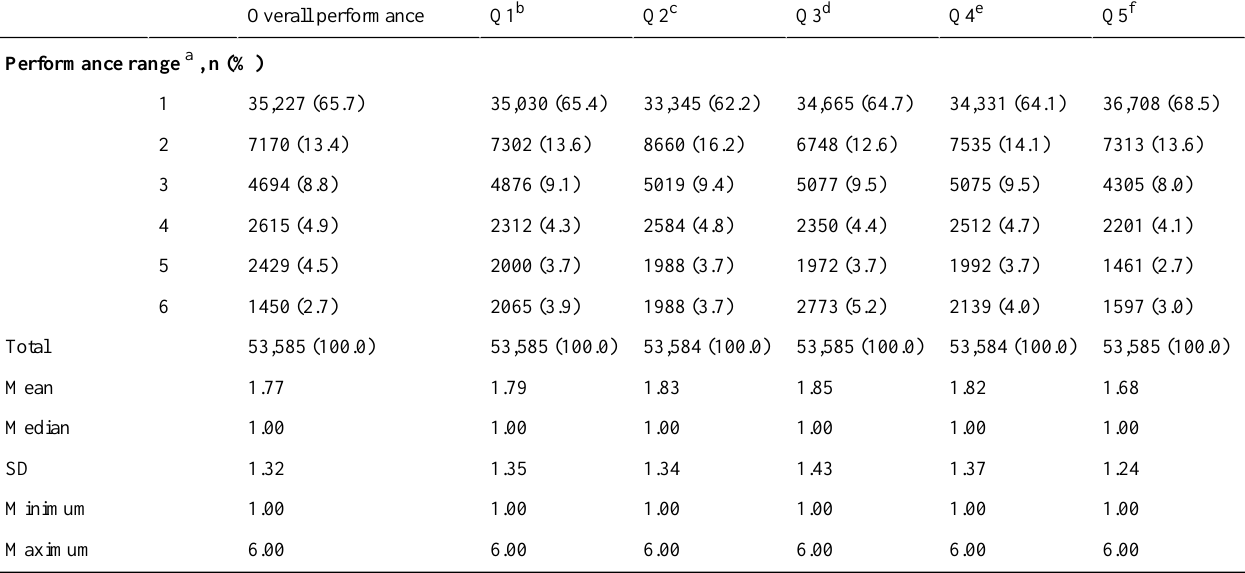
Table 4. Evaluation results of all rated physicians on